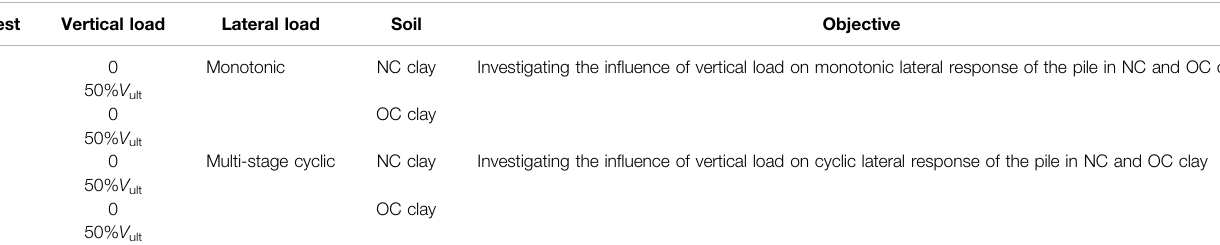
TABLE 2 | Centrifuge test program and objective.